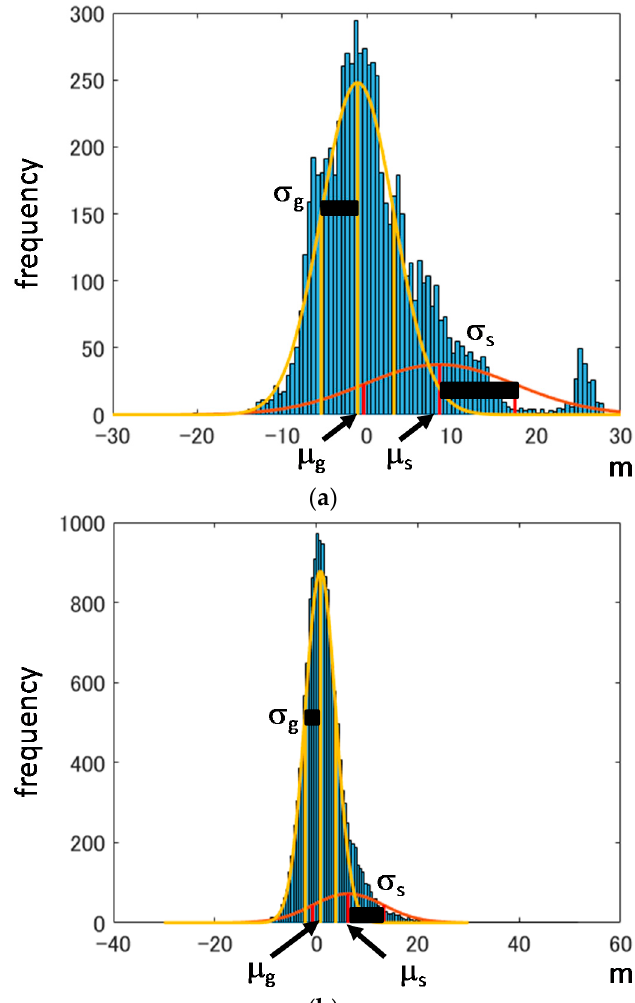
Figure 5. DSM error probability distributions of gPS and sPS. μ g and μ s denote the means of the probability distributions of gPS and sPS, respectively. μ g and μ s denote the standard deviations of the probability distributions of gPS and sPS, respectively. The bin of the horizontal axis was set to 0.5 m. ( a ) Area A and ( b ) Area B.